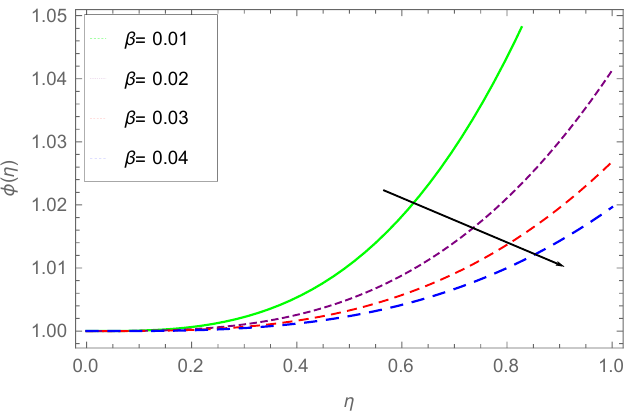
Figure 16. Impact of β on φ ( η ) , when Nt = 0.1, Nb = 0.3, Sc = 0.3, St = 0.1.